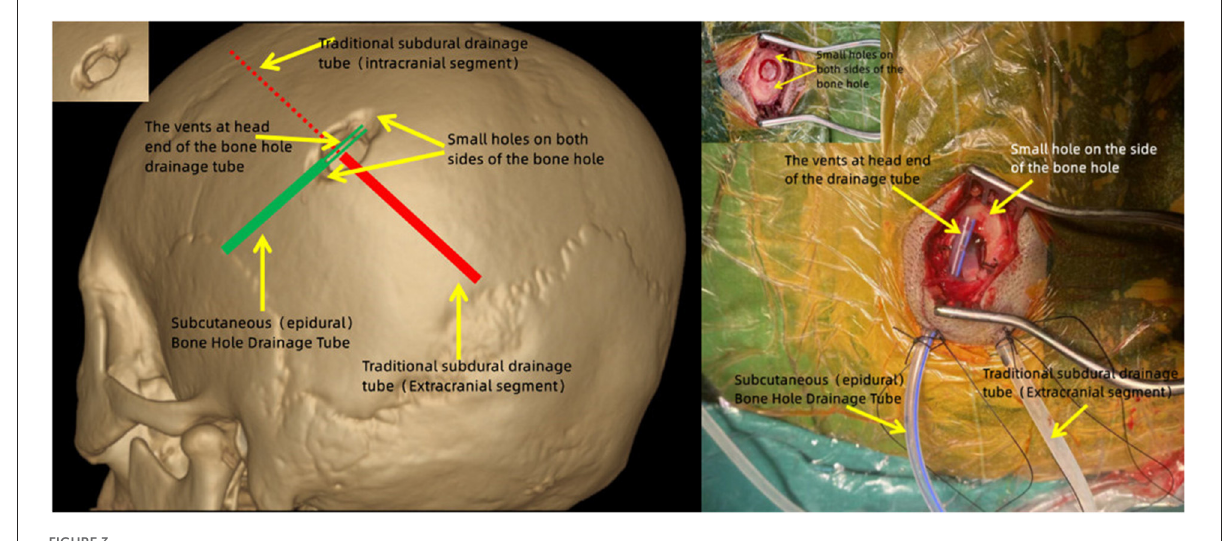
FIGURE3 Schematic diagram of the active bone hole drainage